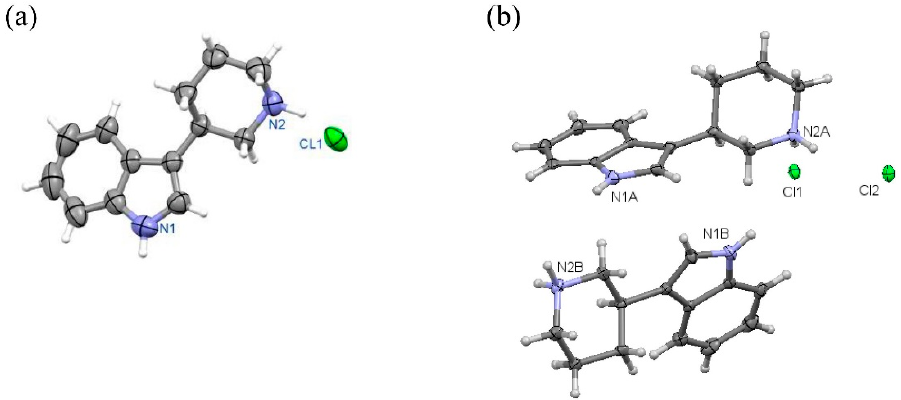
Figure 10. Perspective view of molecules: (R)-10a in orthorhombic ( a ) and monoclinic ( b ) polymorph.